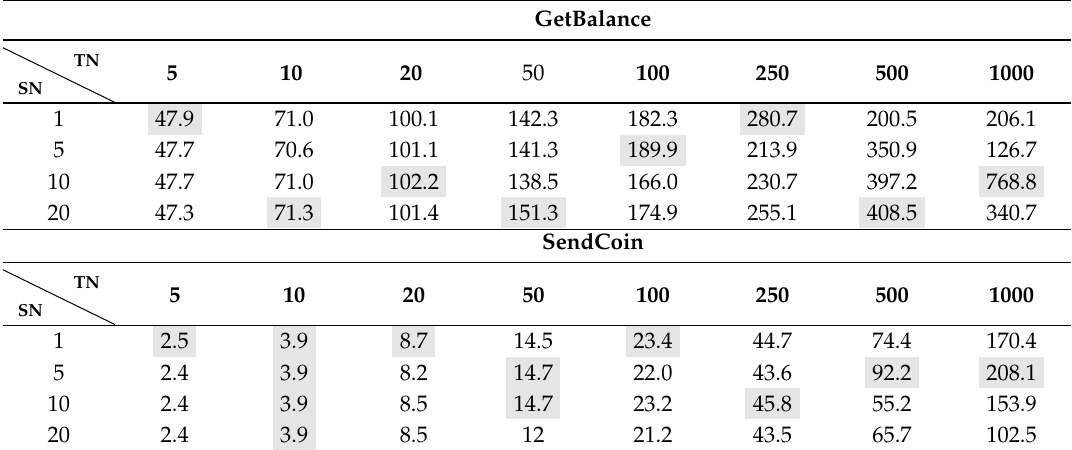
Table 2. Transactions per second (TPS) of GetBalance and SendCoin .